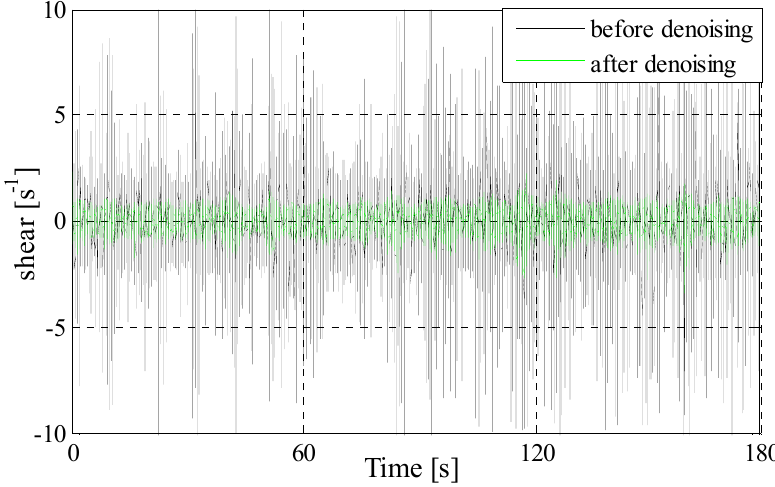
Figure 5. Comparison of signals before and after noise elimination in time domain.